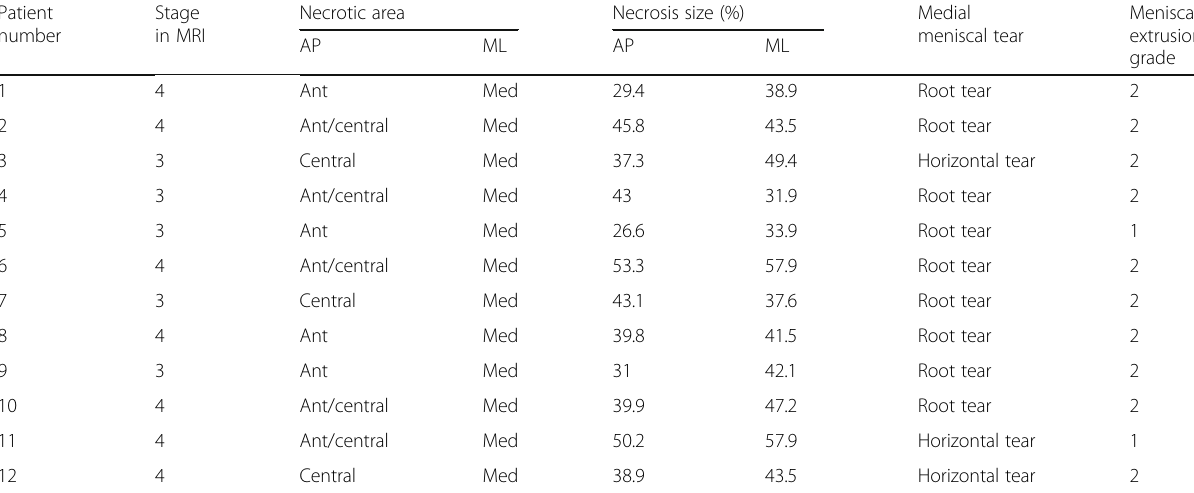
Table 4 Magnetic resonance imaging (MRI) findings of the patients Patient